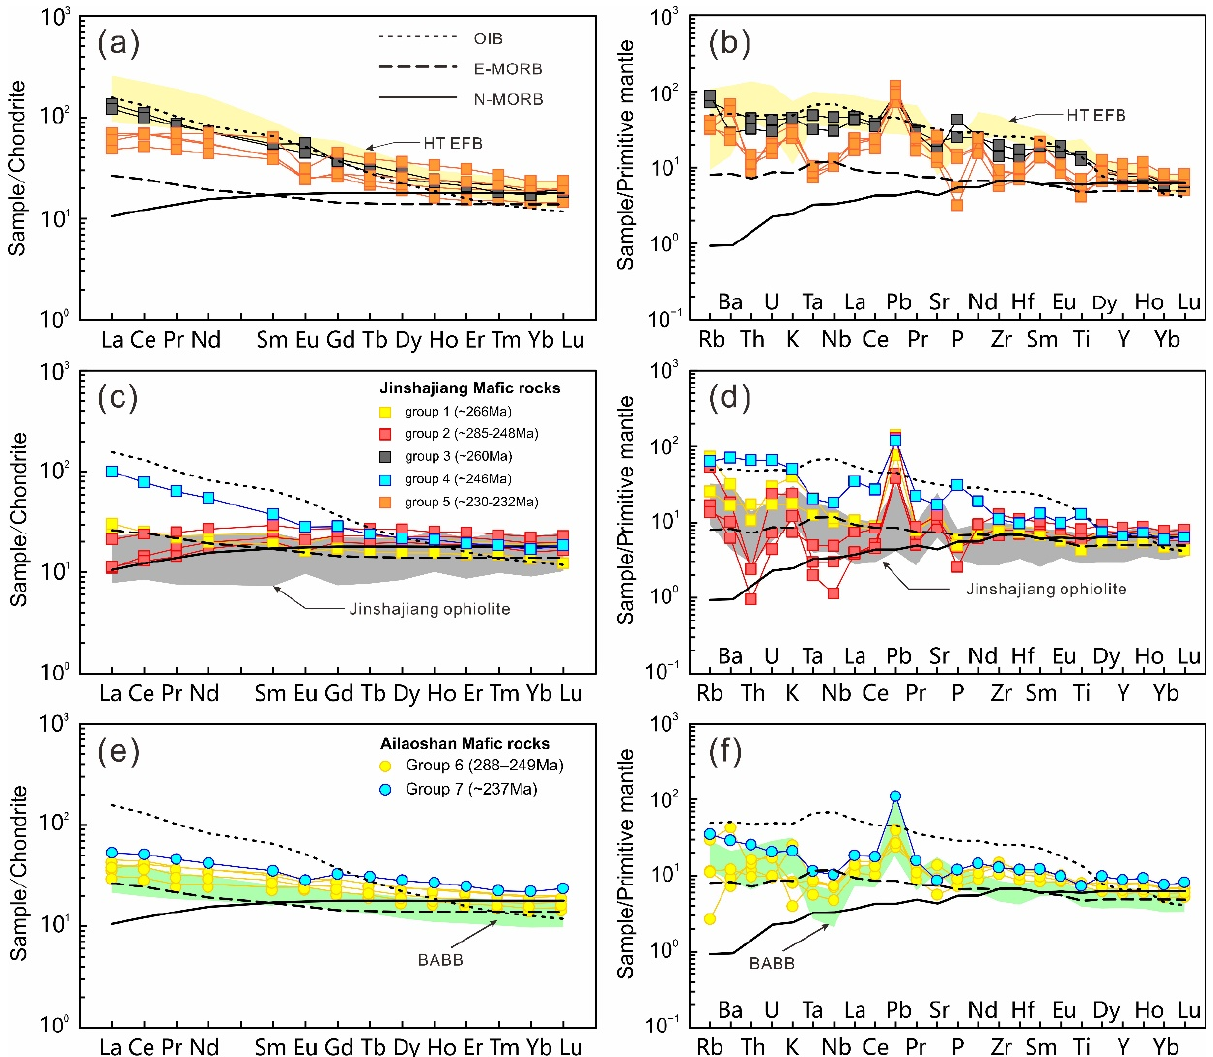
Figure 6. ( a , c , e ) Chondrite-normalized REE patterns and ( b , d , f ) primitive mantle-normalized trace element patterns for mafic and metamafic rocks from the JASB. Normalized values for primitive mantle and chondrite are from [98]. Data for N-MORB, E-MORB, and OIB are from [98].